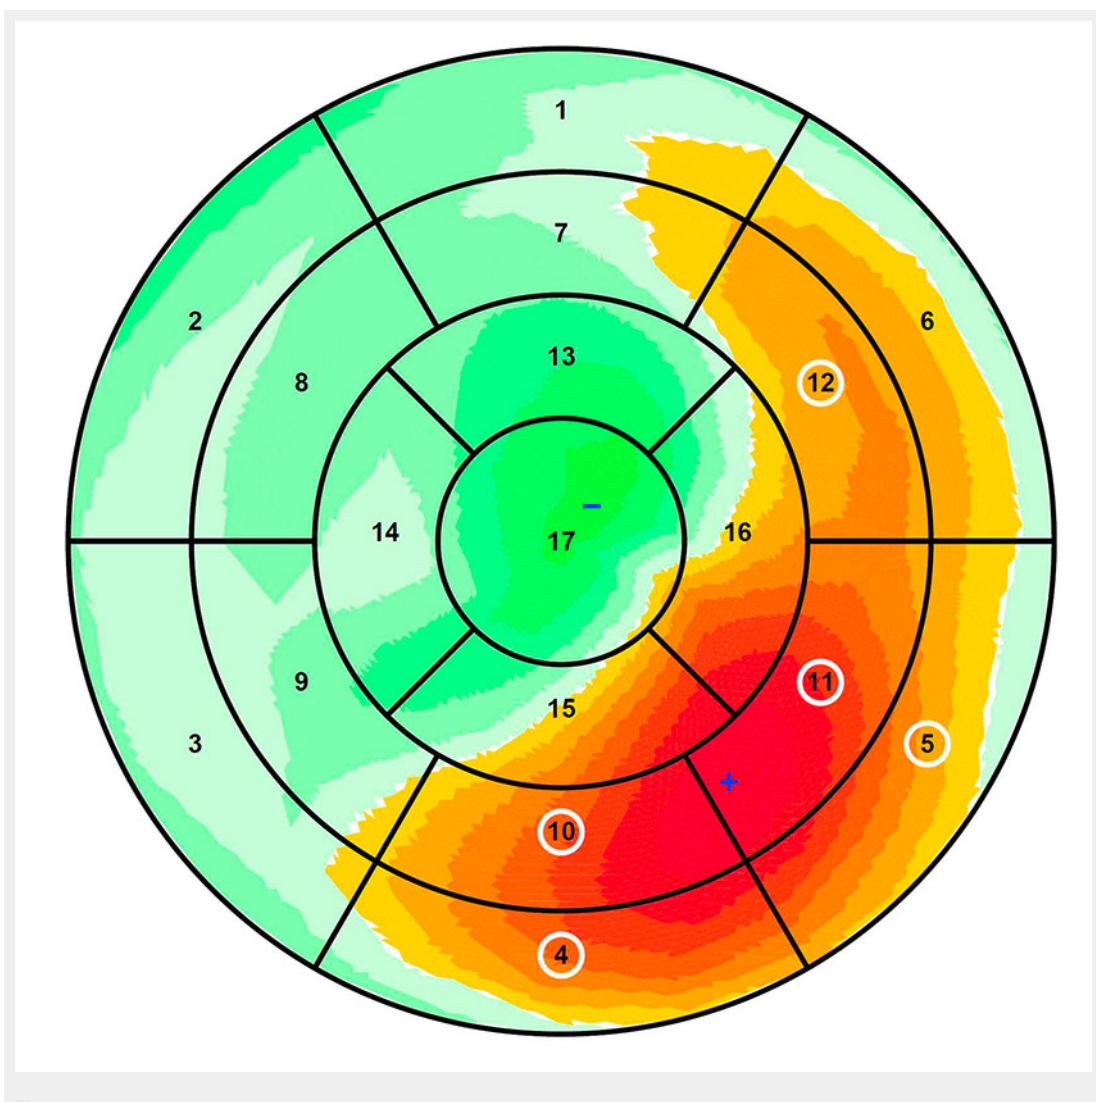
Figure 2 Polarmap of the unipolar epicardial surface potentials obtained at the J-point with ECG imaging in a patient with an left circumflex artery occlusion. Epicardial unipolar potential distribution obtained from J-point measurements. Yellow to red areas indicate positive potentials and green areas indicate negative potentials. Following the American Heart Association standard 17 segment model, the central part of the image corresponds to the left-ventricular apex and the outermost segments correspond to the basal part of the left ventricular